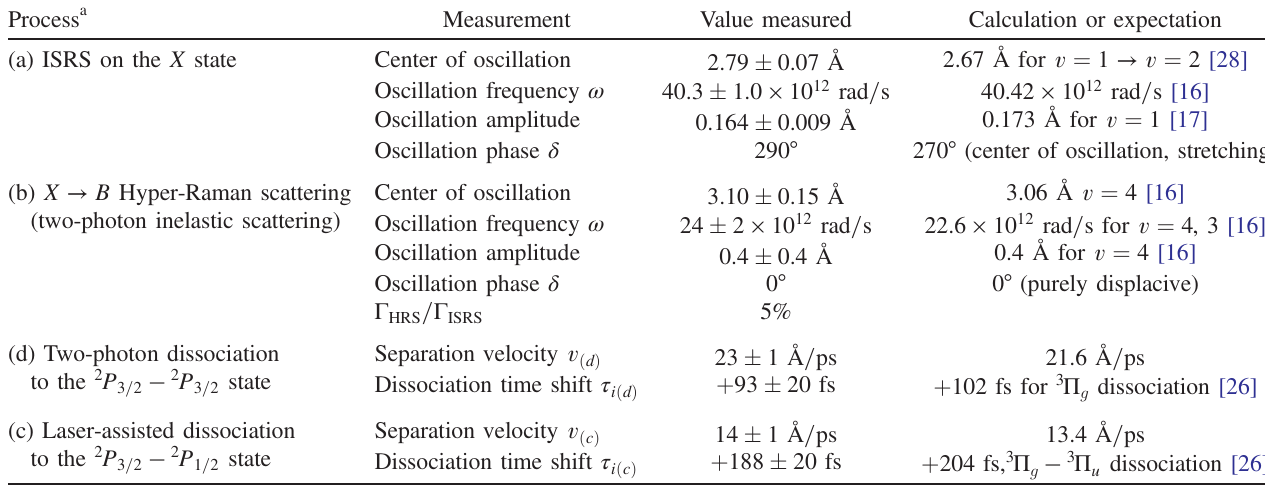
I. This table is a summary of all the multiphoton absorption and scattering measurements described in this